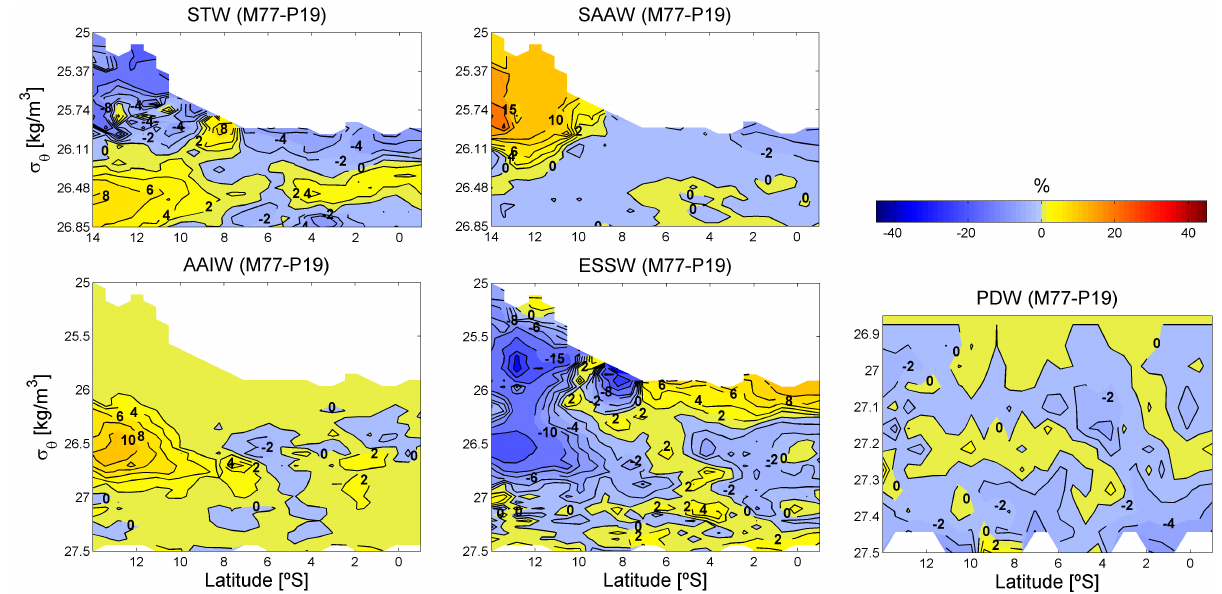
Fig. 9b. Water mass changes (%) in density space between March 1993 and February 2009 (M77–P19) for subtropical water (STW), subantarctic water (SAAW), antarctic intermediate water (AAIW), equatorial subsurface water (ESSW) and pacific deep water